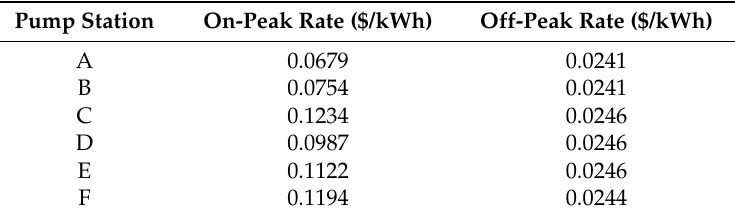
Table 4. Electricity tariffs of the Richmond WDS.